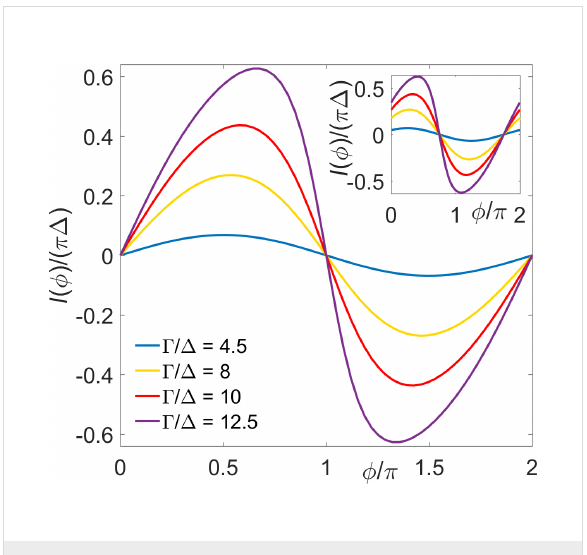
pared to the U = 0 case in Figure 2, interactions push together pairs of Andreev bands, e.g., the pair corresponding to in